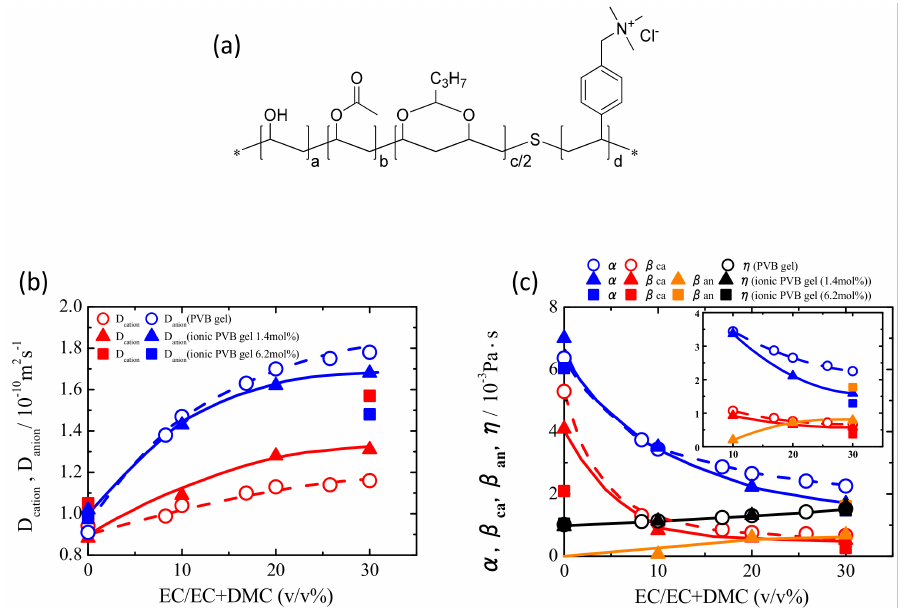
Figure 19. ( a ) Chemical structure of the ionic PVB polymer. ( b ) D ca (red symbols) and D an (blue symbols) and ( c ) η , α , β ca , β an of the PVB gel ( ) and ionic PVB gels ( (cid:78) ; 1.4 mol%, (cid:4) ; 6.2 mol%) (cid:35) with 1 M LiTFSI/EC + DMC as a function of EC fraction of the binary solvent. EC fraction change is associated with the change in the solvation structure of lithium cations. Reprinted with permission from [18]. Copyright 2014 ACS